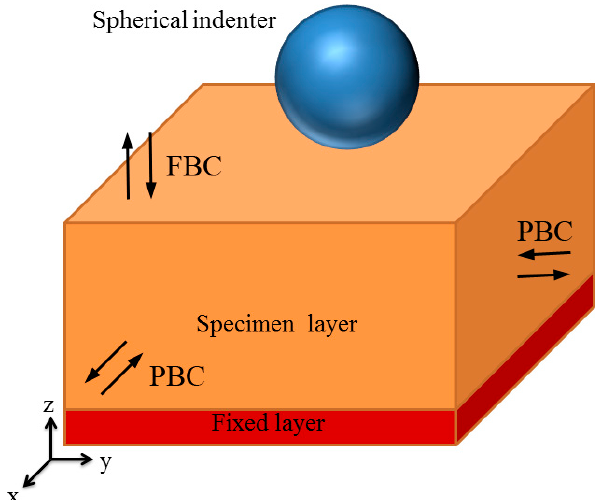
Figure 1. Set-up for indentation on GaN film with spherical indenter.